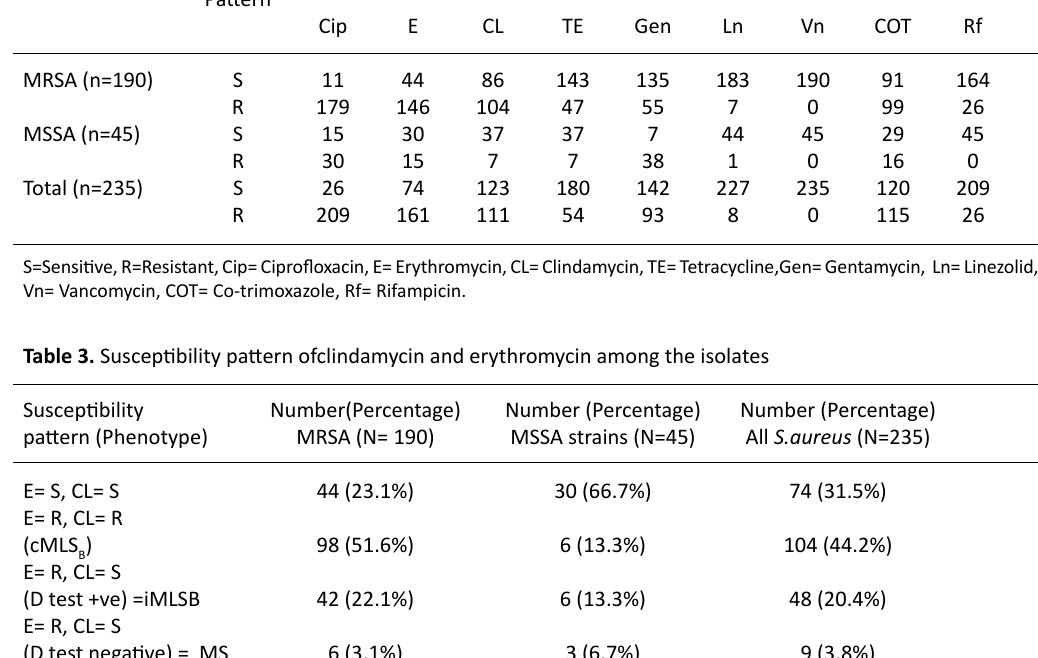
Table 2. Antibiotic sensitivity pattern of the S.aureus isolates Isolates Sensitivity Anti Microbial Agent / N Pattern Cip E CL TE Gen Ln MRSA (n=190) S MSSA (n=45) S Total (n=235)